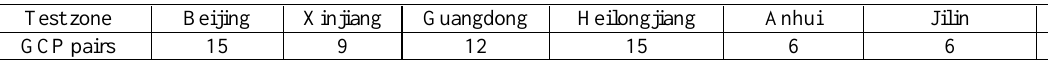
Table 2. Ground control poins distribution